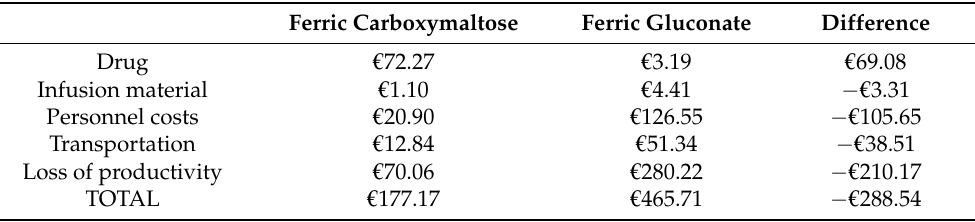
Table 5. Description of costs per patient over 24 weeks associated with use of ferric carboxymaltose and costs estimated in a ferric gluconate scenario in the whole population ( n = 59). Ferric Carboxymaltose Ferric Gluconate Difference Drug € 72.27 € 3.19 € 69.08 Infusion material € 1.10 € 4.41 − € 3.31 €